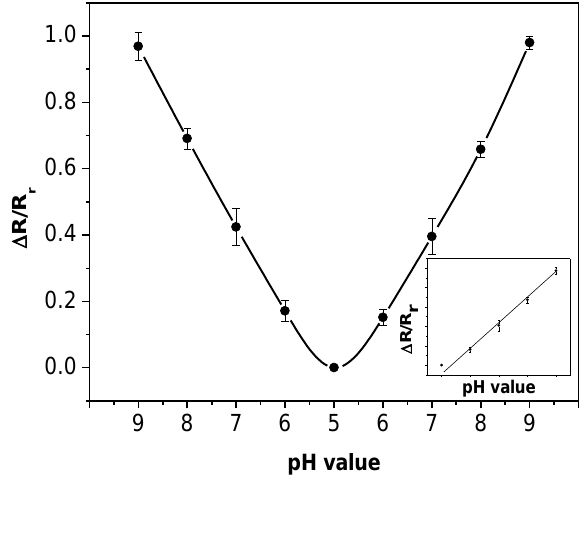
Figure 7. Normalized resistances versus pH values for five SWNT-based sensors. Inset: the linear relationship between the normalized sensor resistance and the pH